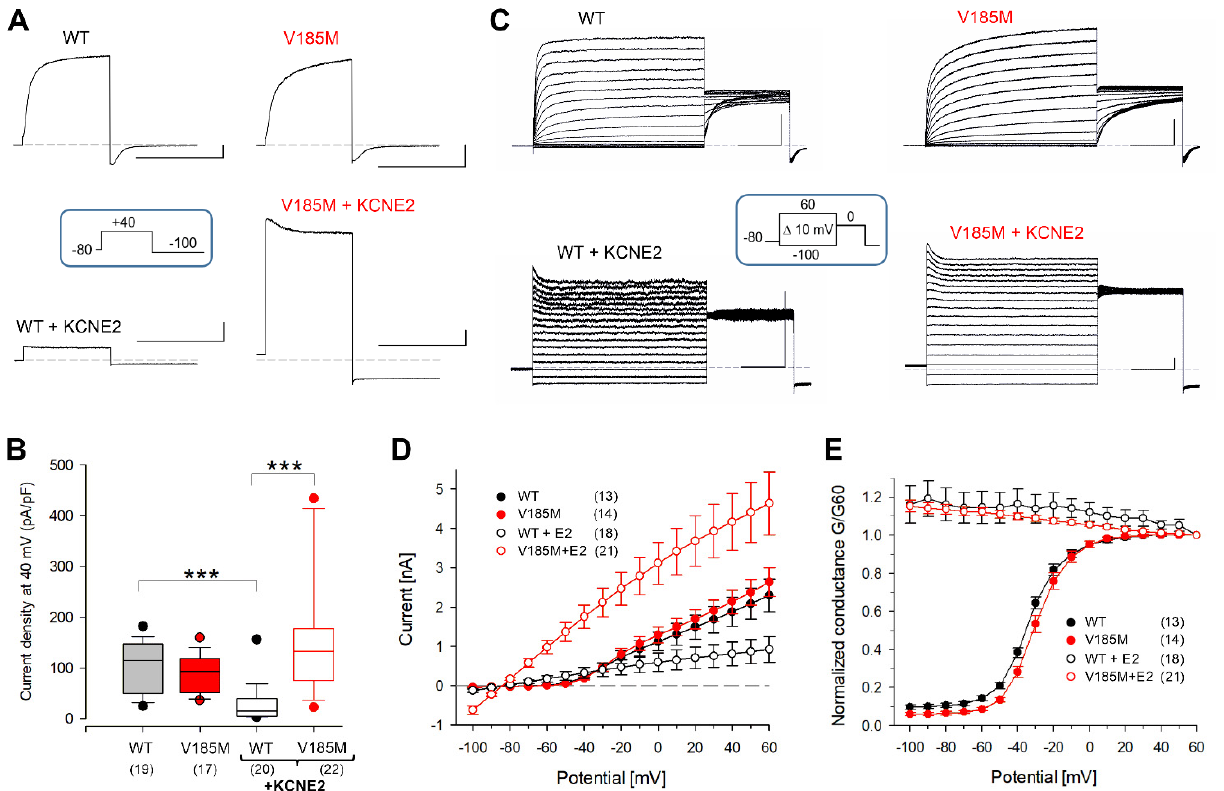
Figure 1. KCNQ1 variant V185M leads to high current densities in cells expressing KCNQ1-KCNE2 (Q1E2) heteromers. Whole-cell membrane currents were recorded in CHO cells expressing wild- type (WT) or V185M KCNQ1 channels alone or together with KCNE2. ( A ) Typical current traces recorded with a 500 ms test pulse to 40 mV. ( B ) Distribution of current densities determined with test pulses shortly after break-through. Asterisks indicate significant differences between groups; *** p < 0.001. ( C ) Typical families of current traces obtained with the indicated standard double pulse protocol, consisting of a 2 s variable P1 pulse and a constant P2 pulse to 0 mV. ( D ) Current ampli- tudes (means ± SEM) at the end of the 2 s P1 pulse plotted against P1 potential. ( E ) Conductance– voltage (GV) relation: normalized instantaneous P2 current amplitudes (means ± SEM) plotted against P1 potential. Numbers of experiments in ( B , D , E ) are given in parentheses; scale bars in ( A , C ) denote 0.5 nA and 0.5 s; standard extracellular (ECS) and intracellular solution (ICS). WT: WT KCNQ1; V185M: V185M-KCNQ1.